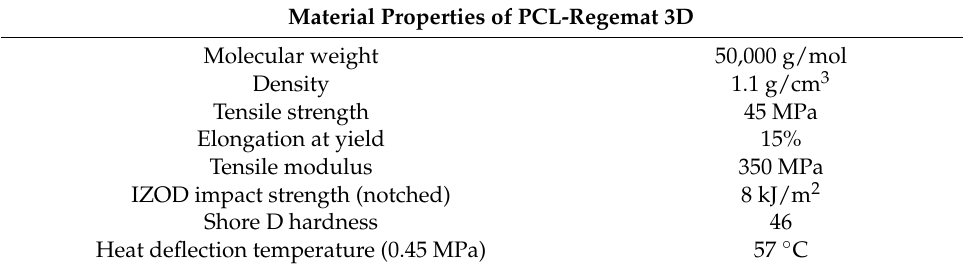
Table 1. Material Properties of